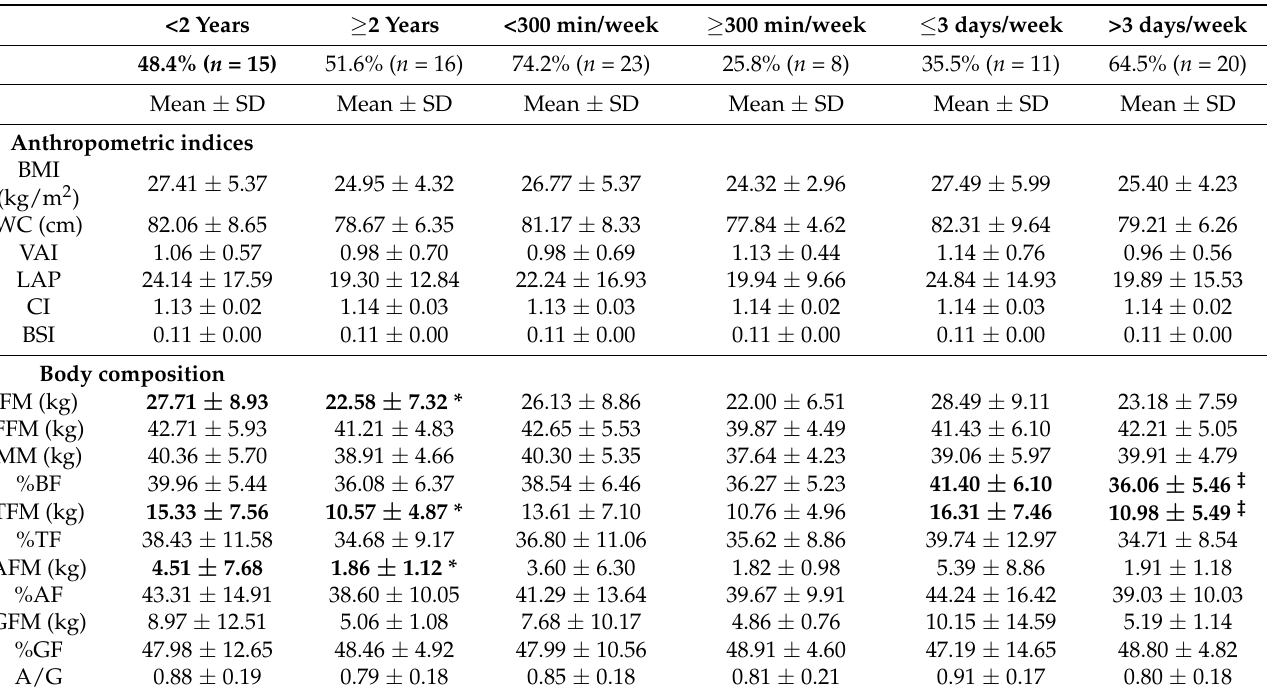
Table 2. Comparison between anthropometric indices and body composition according to time in years, time in minutes per week and weekly frequency of resistance